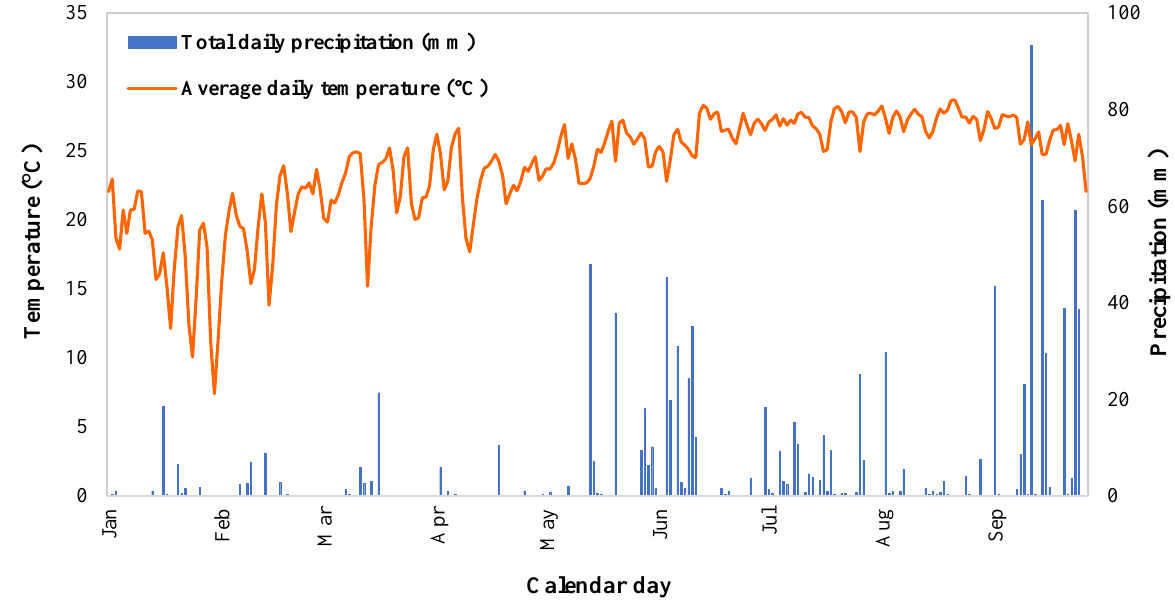
Figure 2. Average temperatures and daily precipitation during the experimental year 2022 (FAWN, 2022).